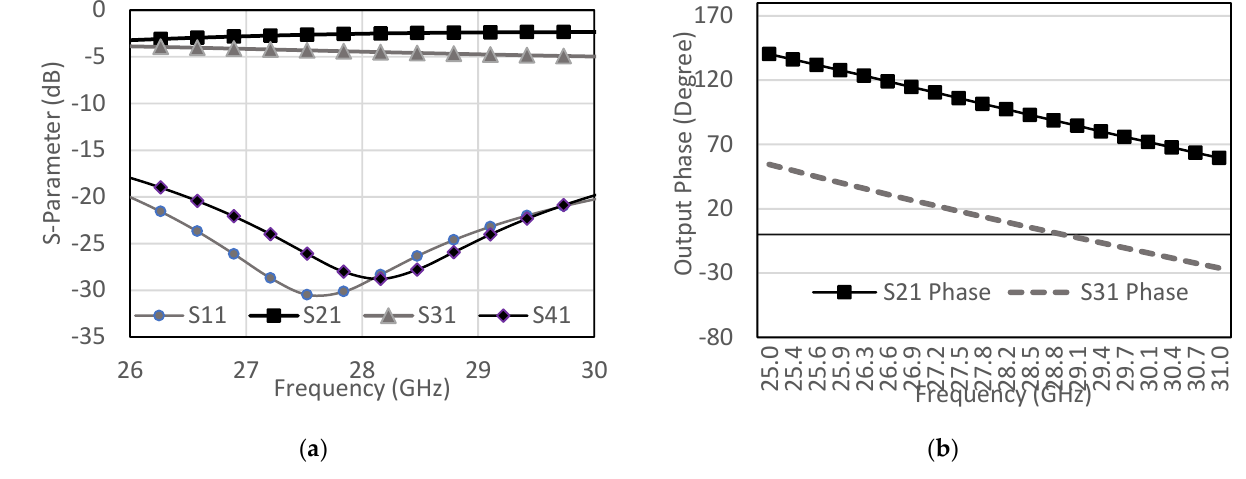
Figure 11. Hybrid structure topology dimensions.